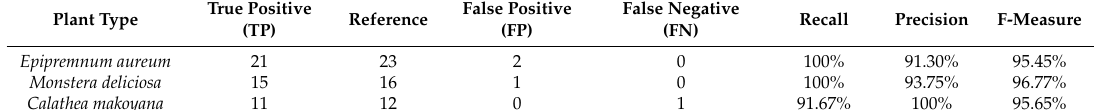
Table 2. Quantitative results of the proposed method.